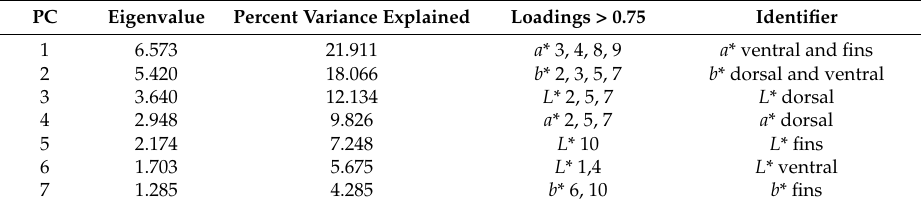
Table A1. PC scores with eigenvalues > 1 retained from a PCA on L * a * b * values of ten spots on the body surface of male Poecilia spp. collected in sulfidic and non-sulfidic waters. For better interpretation of PC scores, the body regions (dorsal, ventral, fins) and their corresponding L * a * b * values contained in a given PC are summarized (‘identifier’) on the basis of axis loadings > 0.75 of the respective PC (the numbers refer to the ten areas on the body for which coloration was quantified).